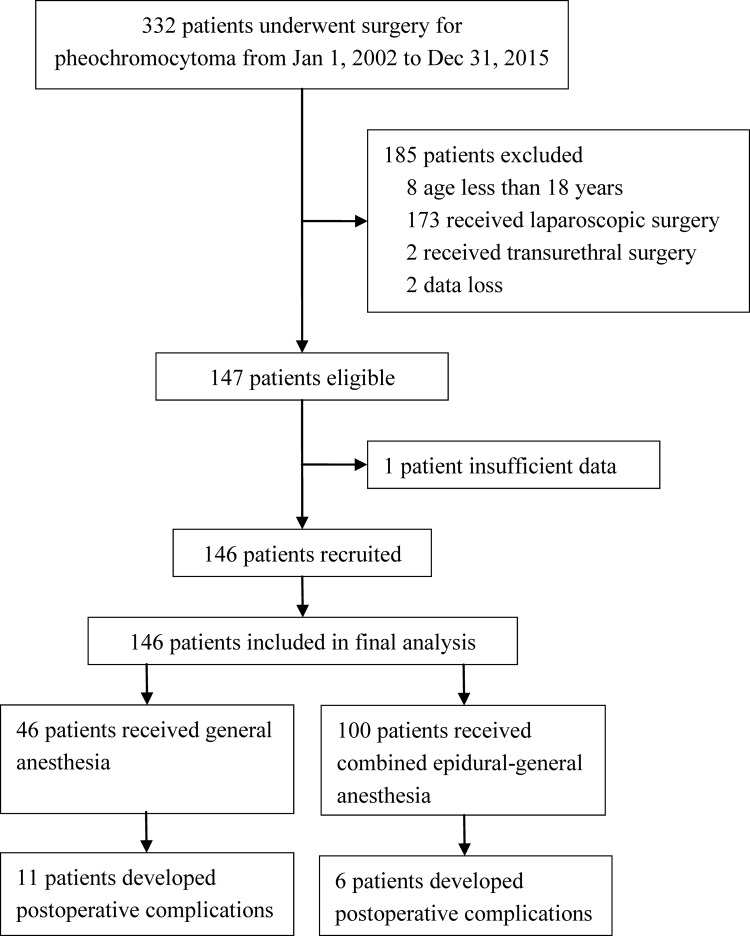
Flow diagram of the study.